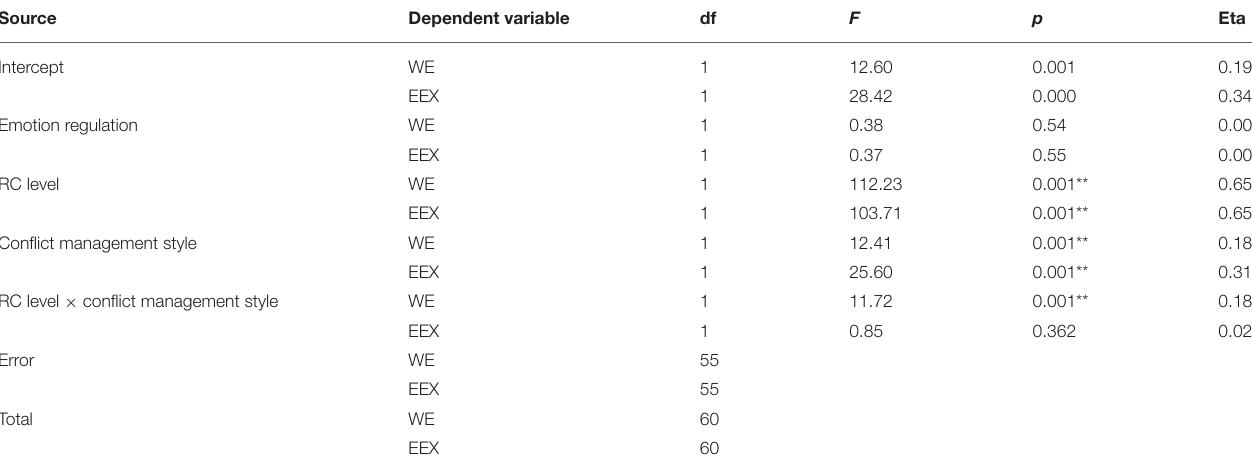
TABLE 4 | Results of MANCOVA: RC intensity level on work engagement and emotional exhaustion.